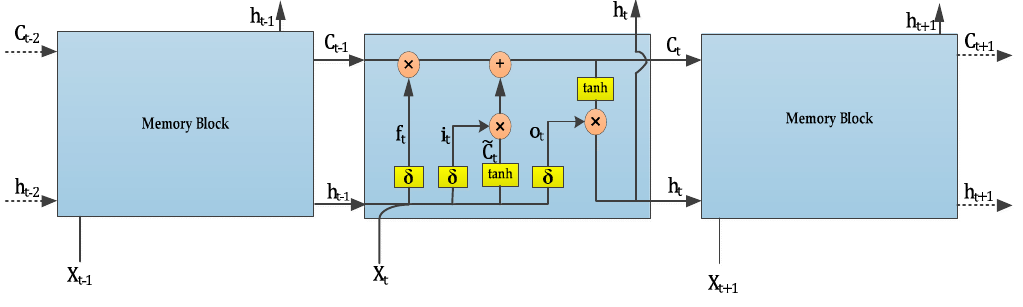
Figure 1. Basic structure of a long short term memory (LSTM) network.